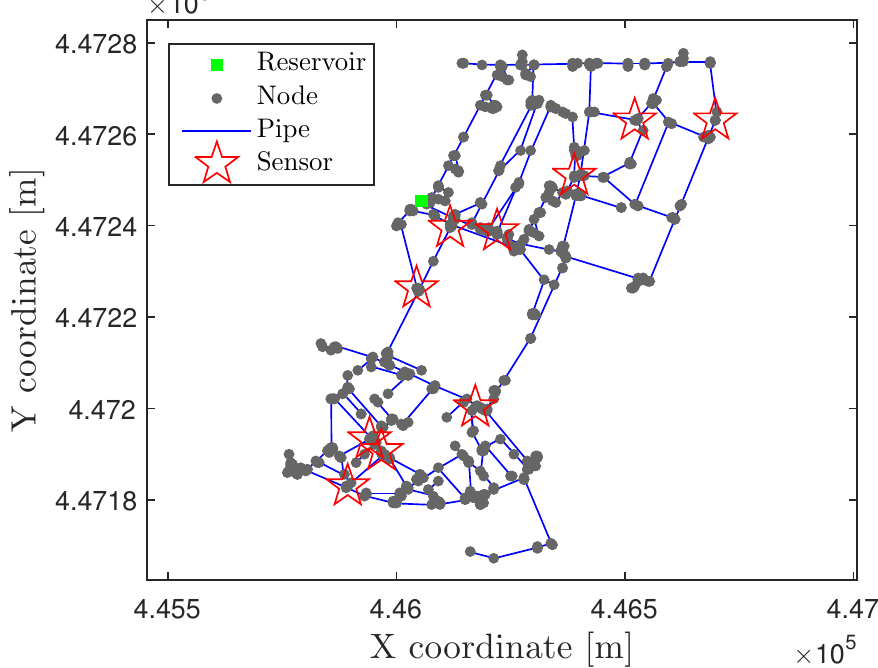
Figure 11. Madrid DMA topological network and sensor